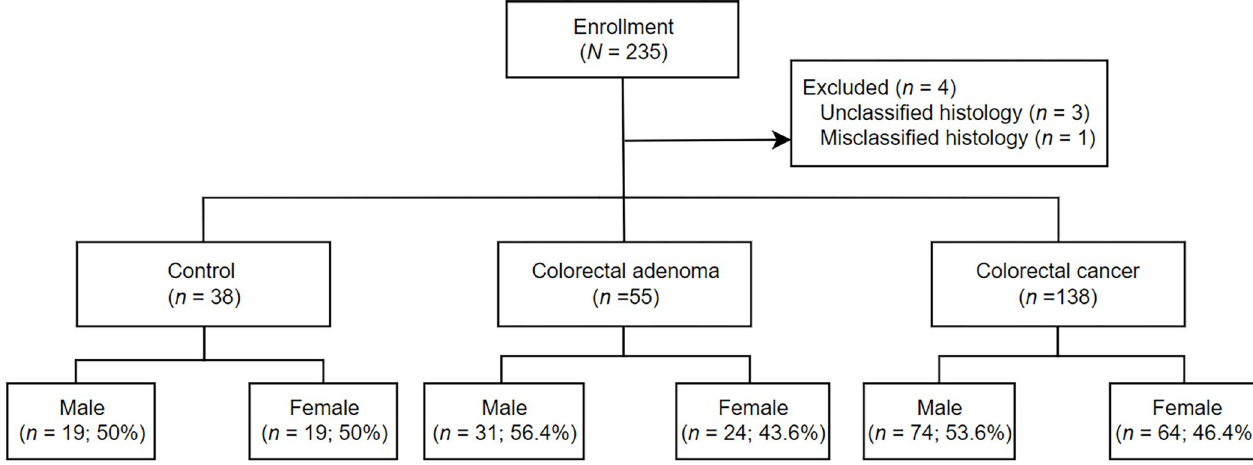
Fig 1. Study flow chart of the enrolled participants and further classification according to sex.